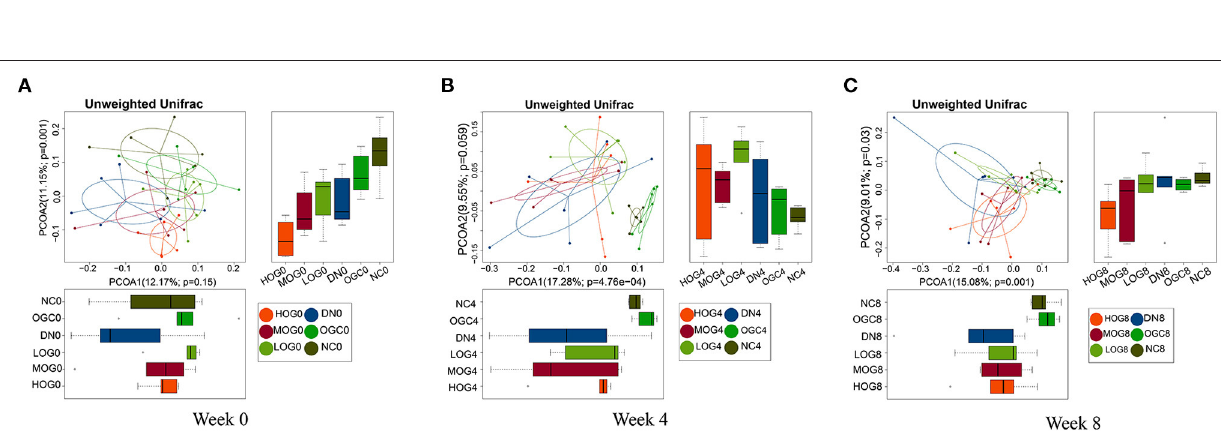
FIGURE 5 | Beta diversity of gut microbiota at 0 (A) , 4 (B) , and 8 (C) weeks. PCoA plots reflect the beta diversity of gut microbiota: the abscissa represents the contribution rate of the first principal component to the sample difference, the ordinate represents the second principal component, and the percentage represents the contribution rate of the second principal component to the sample.